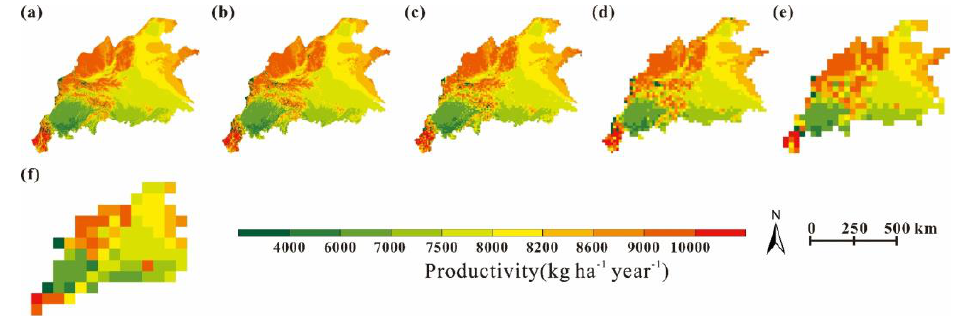
Figure 3. Spatial distribution of multi-resolution potential productivity simulation results in the research area: the spatial resolution is 5 km ( a ), 10 km ( b ), 20 km ( c ), 40 km ( d ), 80 km ( e ), and 160 km ( f ).